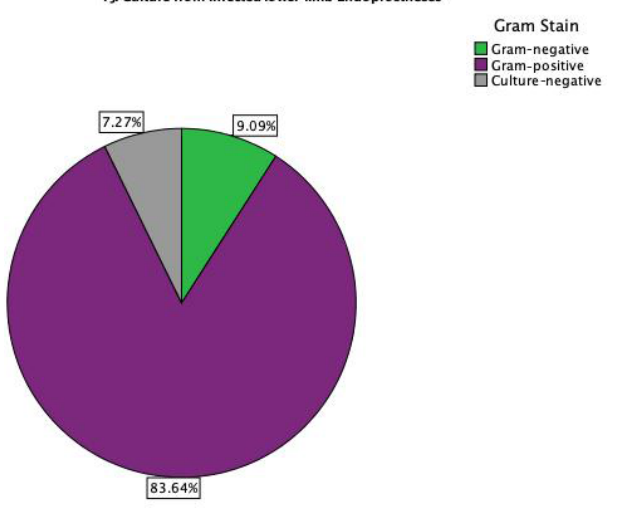
Figure 2. PJI culture results from infected lower-limb